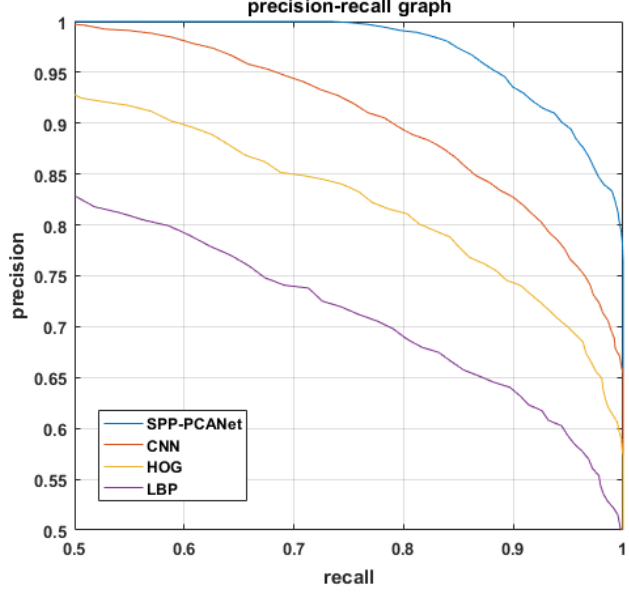
Figure 9. Precision and recall curves of different